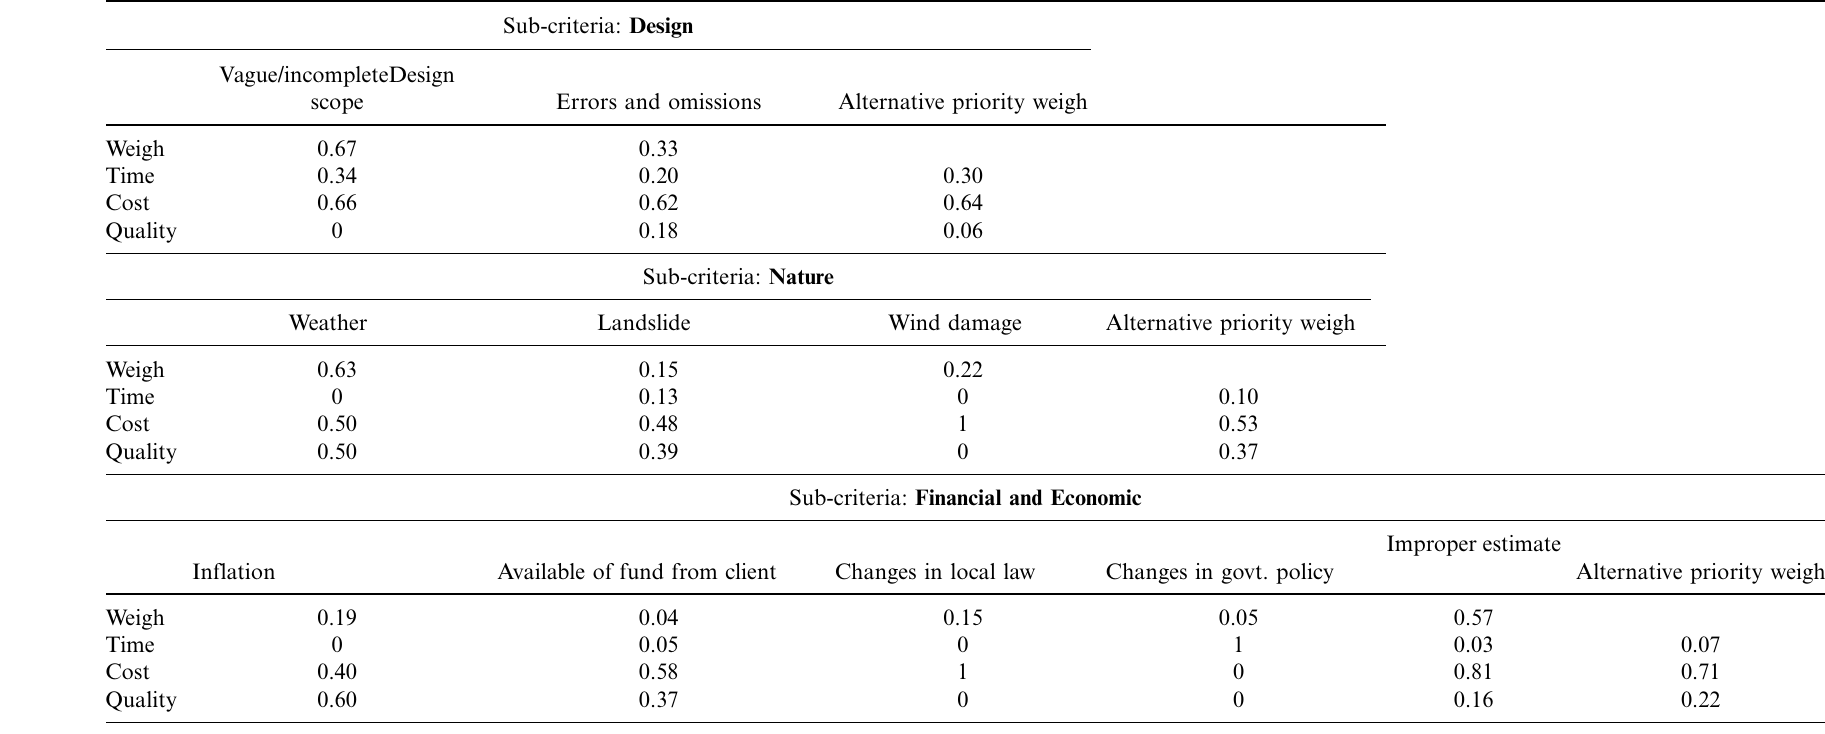
Table 11. Combination of priority